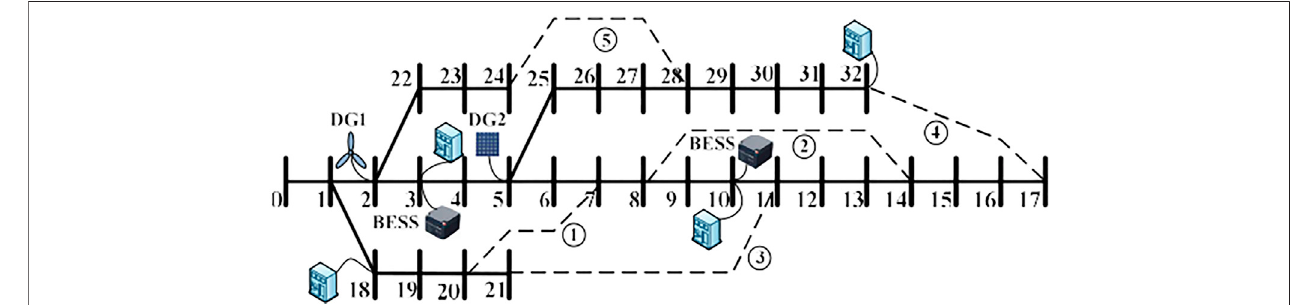
FIGURE 9 | IEEE 33-node system.